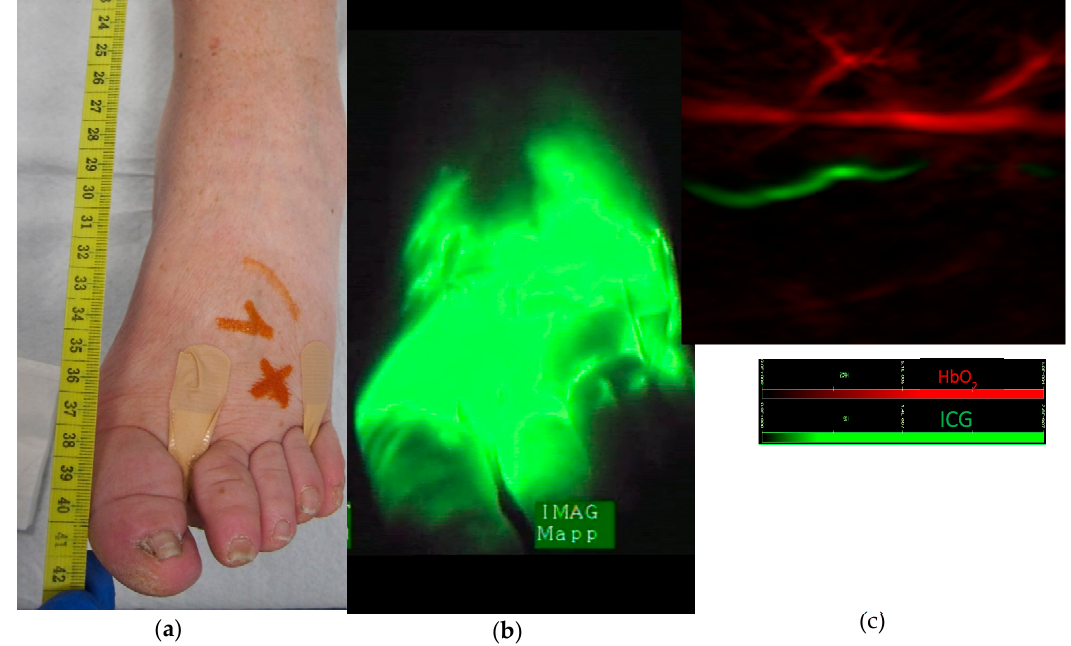
Figure 4. ( a ) Patient with primary lymphedema. ( b ) Diffuse pattern after ICG injection between the toes, no individual lymphatic vessel can be identified ( c ) MSOT identification of lymphatic vessel (green) and vein (red) in the area of diffuse dermal backflow. The precise localization of these identified vessels is marked on the skin with an orange cross (see Figure 4a).